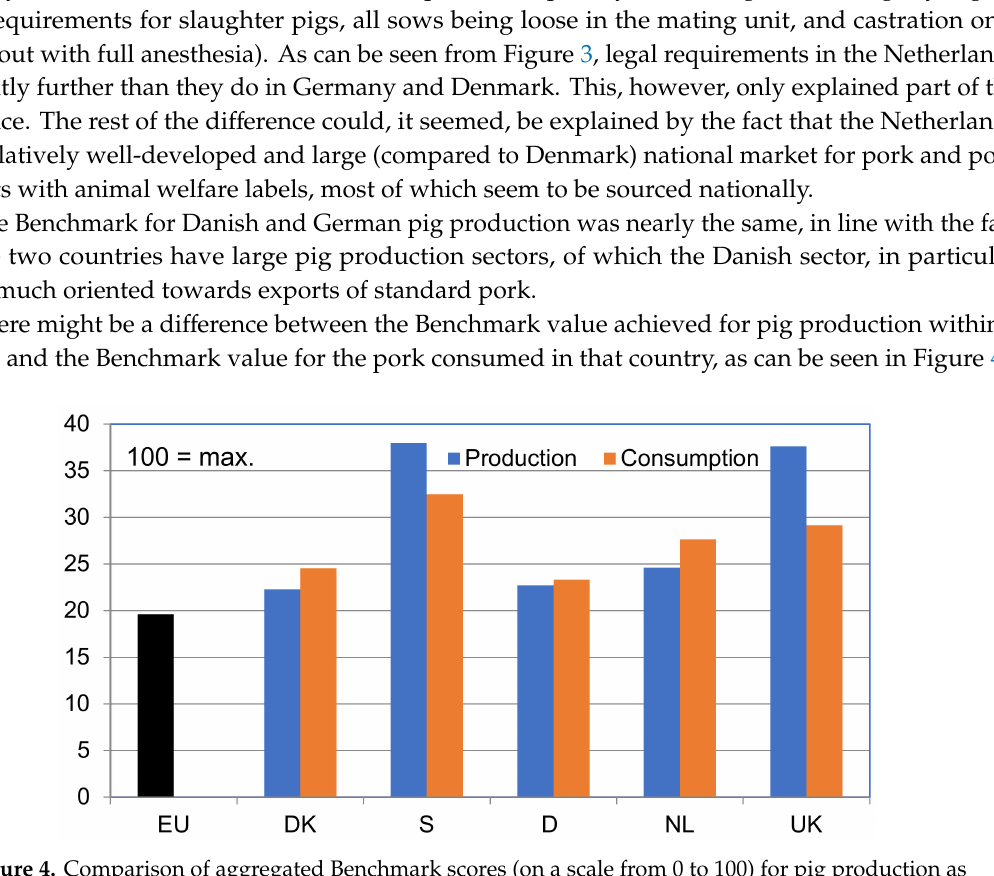
Figure 4. Comparison of aggregated Benchmark scores (on a scale from 0 to 100) for pig production as well as for pork consumption in the five countries studied. The score for the European Union (EU) represents what the Benchmark score would be if all production in a country was based on the EU’s minimal